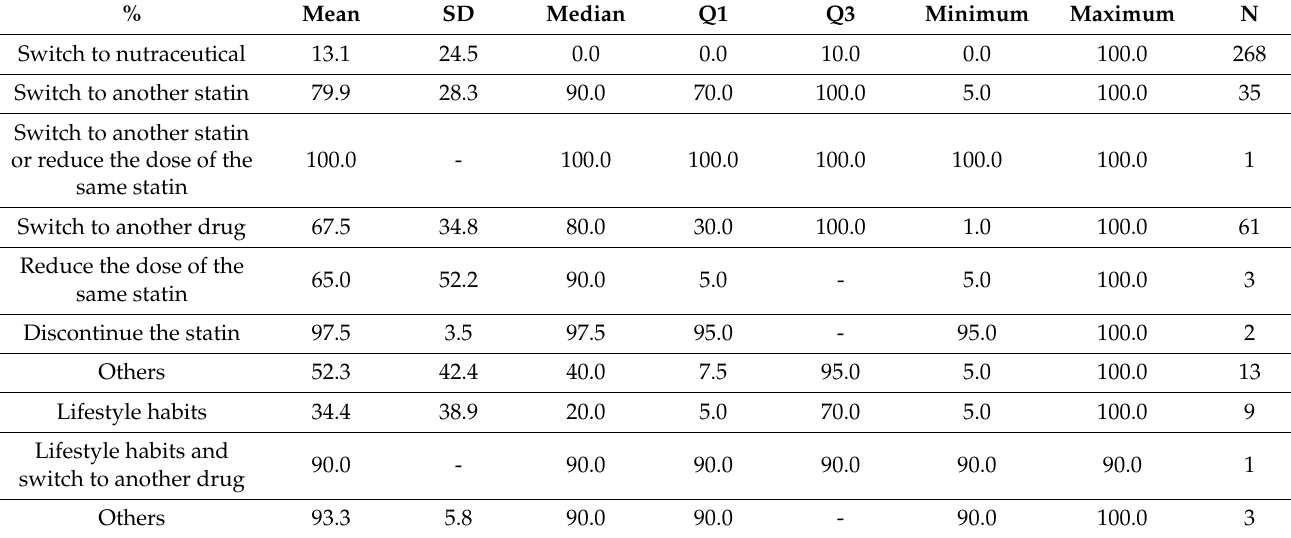
Table 2. Strategies used when there were side-effects to statins.